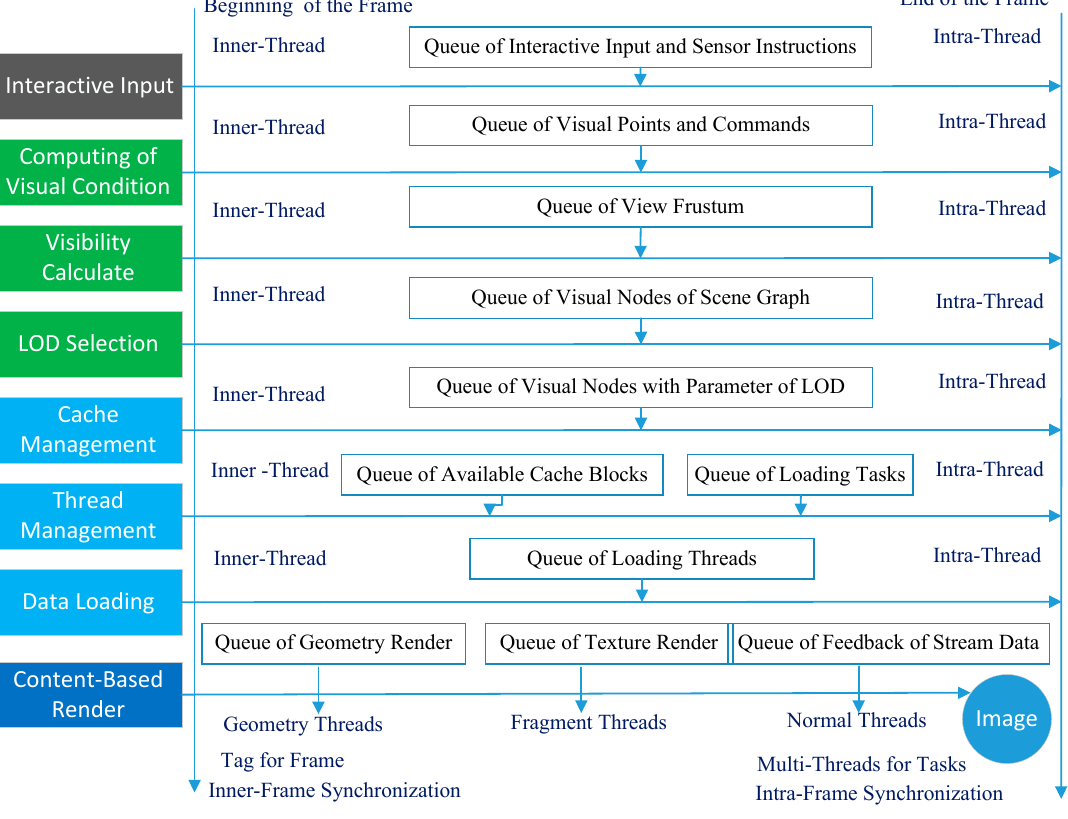
Figure 4. Task parallel collaborative model based on Shared Data Queue of the Pipeline.